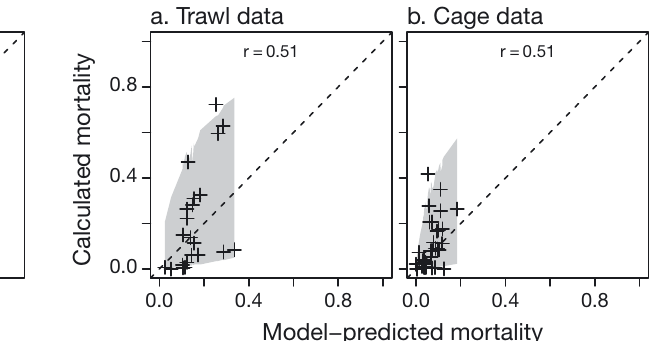
Fig. 4. Model-predicted and calculated salmon lice-induced mortality in sampled fish in the (a) trawl and (b) sentinel cage data. Mortality is calculated from lice abundances pre- dicted from the main model (x -axes) or from observed lice abundances (y -axes). Crosses: mean for one management area and year; grey areas: 90% intervals for empirical vari- ation around the expected mortality. Pearson’s correlation coefficient (r) between predictions and observations is given; N = 22 in (a), N = 37 in (b). Dashed lines: 1:1